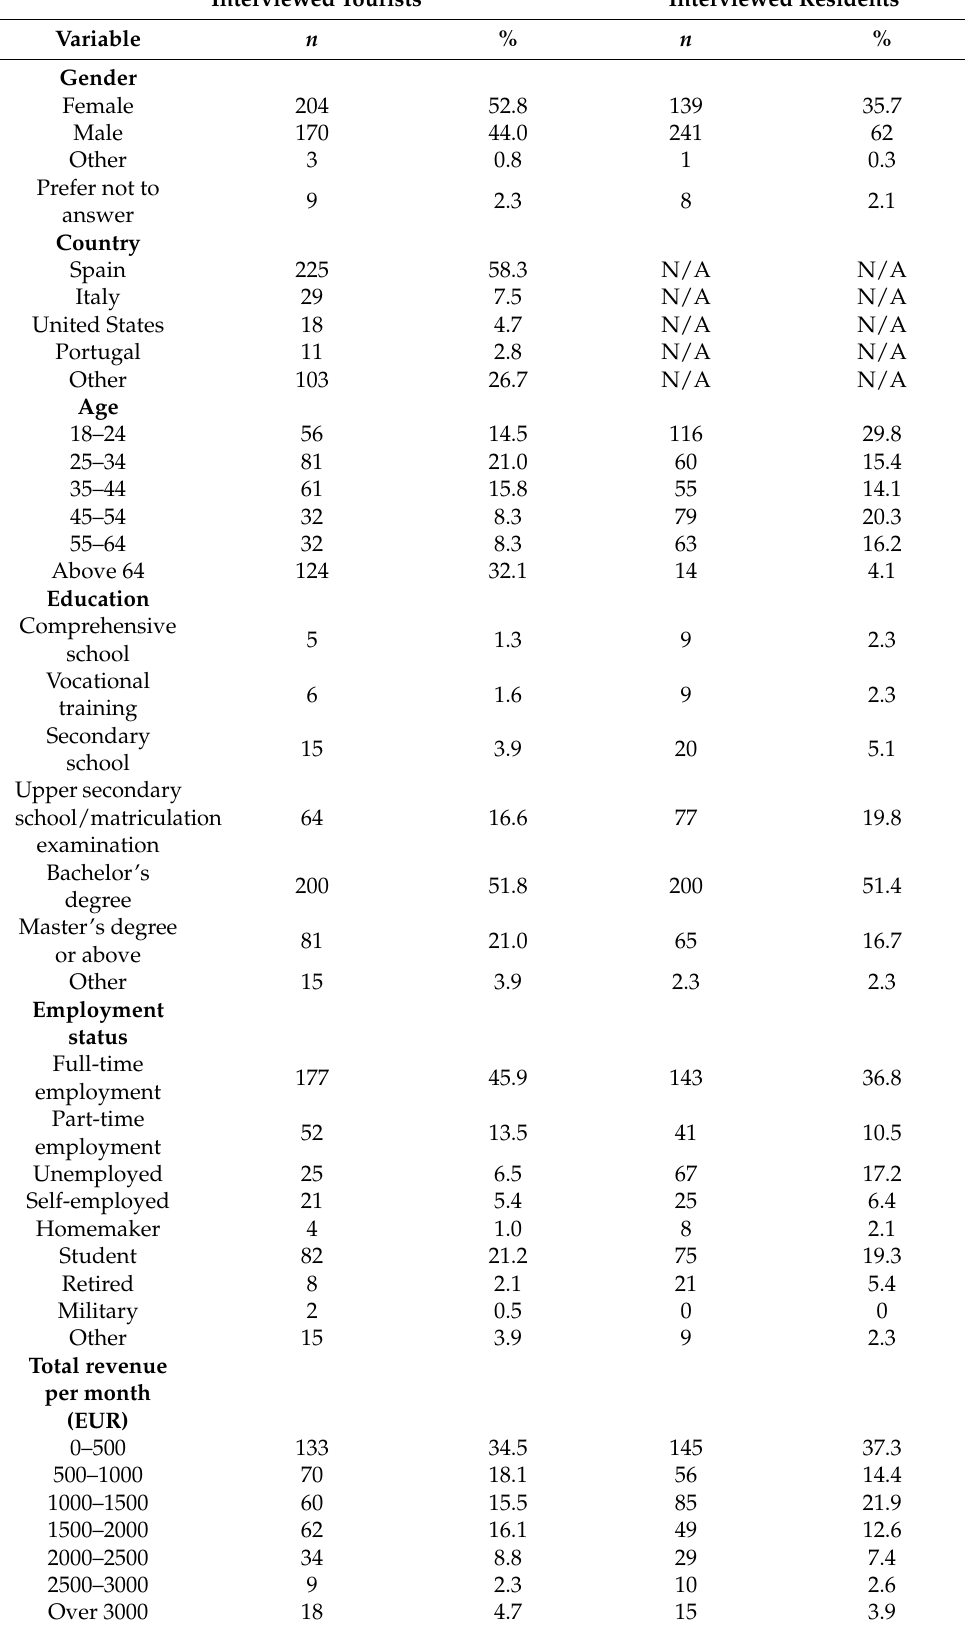
Table 2. Socio-demographic profile of the interviewed residents and